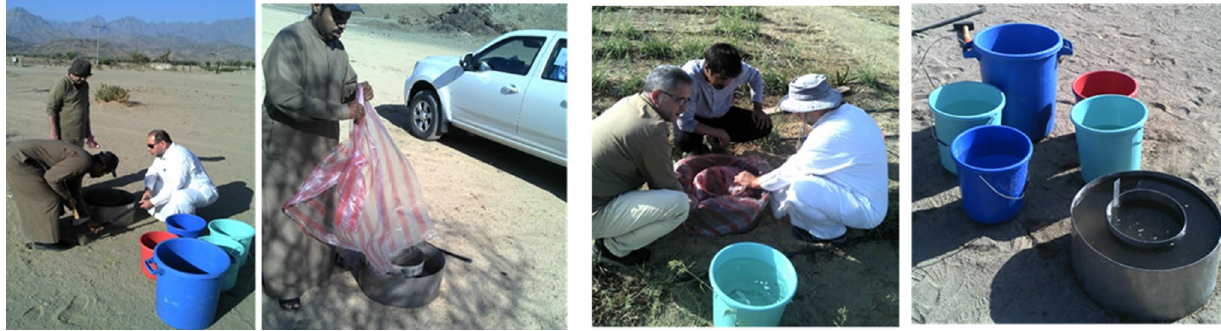
Fig. 4 Field infiltration tests using the double-ring